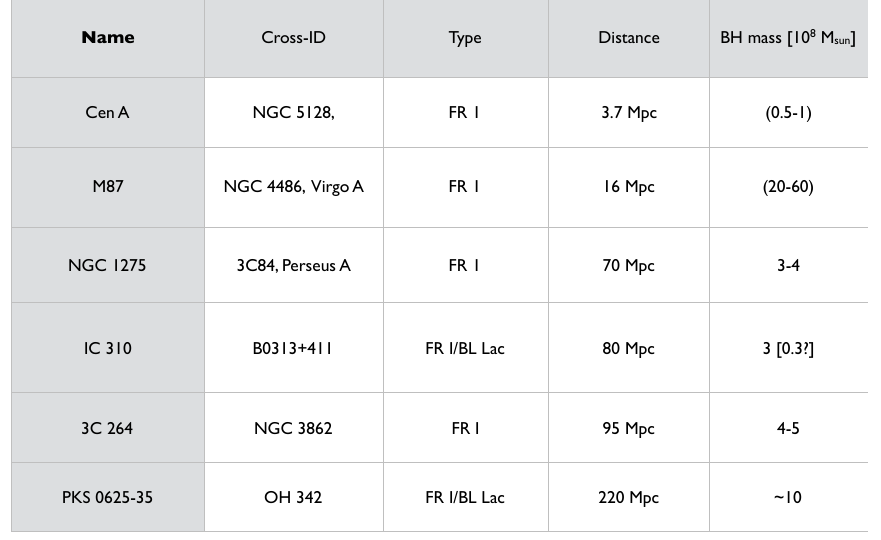
Figure 1. Radio galaxies reported at VHE energies, including estimates for their black hole masses. Cross-IDs give their alternative source identifications. Two sources, IC 310 and PKS 0625-35, may be of a transitional